Question: Write the caption for this figure.
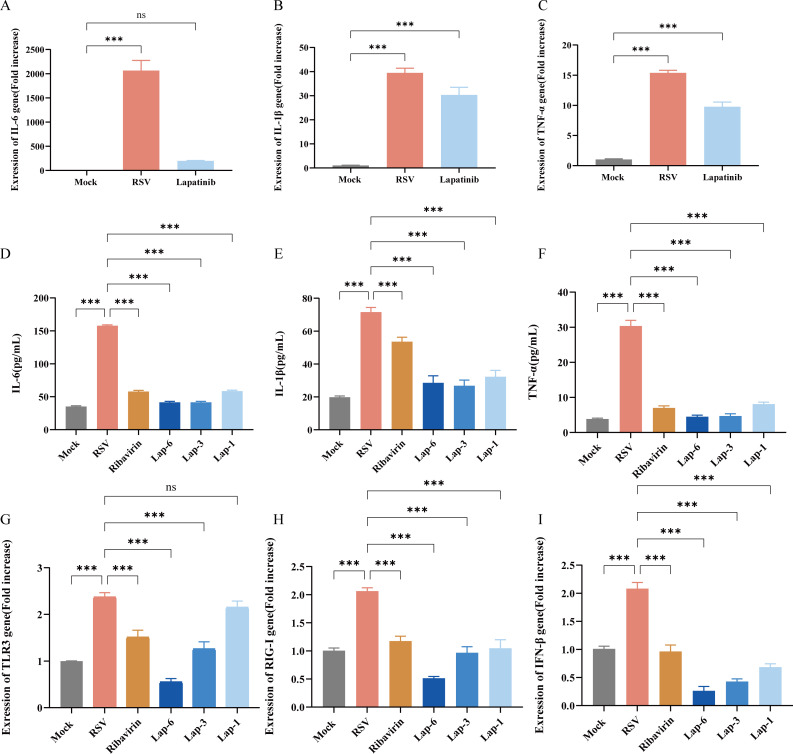
Answer: Effect of drugs on inflammatory factors in RSV-infected cells. ( A–C ) mRNA expression of IL-6, IL-1β, and TNF-α in A549 cells; the drug concentration of lapatinib was 3.125 μM. ( D–F ) mRNA expression of TLR-3, RIG-I, and IFN-β in A549 cells. ( G–I ) Protein levels of IL-6, IL-1β, and TNF-α in A549 cell culture supernatant, as determined by ELISA. The treatments included ribavirin (400 μM) and lapatinib: lap-6 (6.25 μM), lap-3 (3.125 μM), and lap-1 (1.56 μM). The data are presented as the means ± SDs. * P < 0.05, ** P < 0.01, *** P < 0.0001.